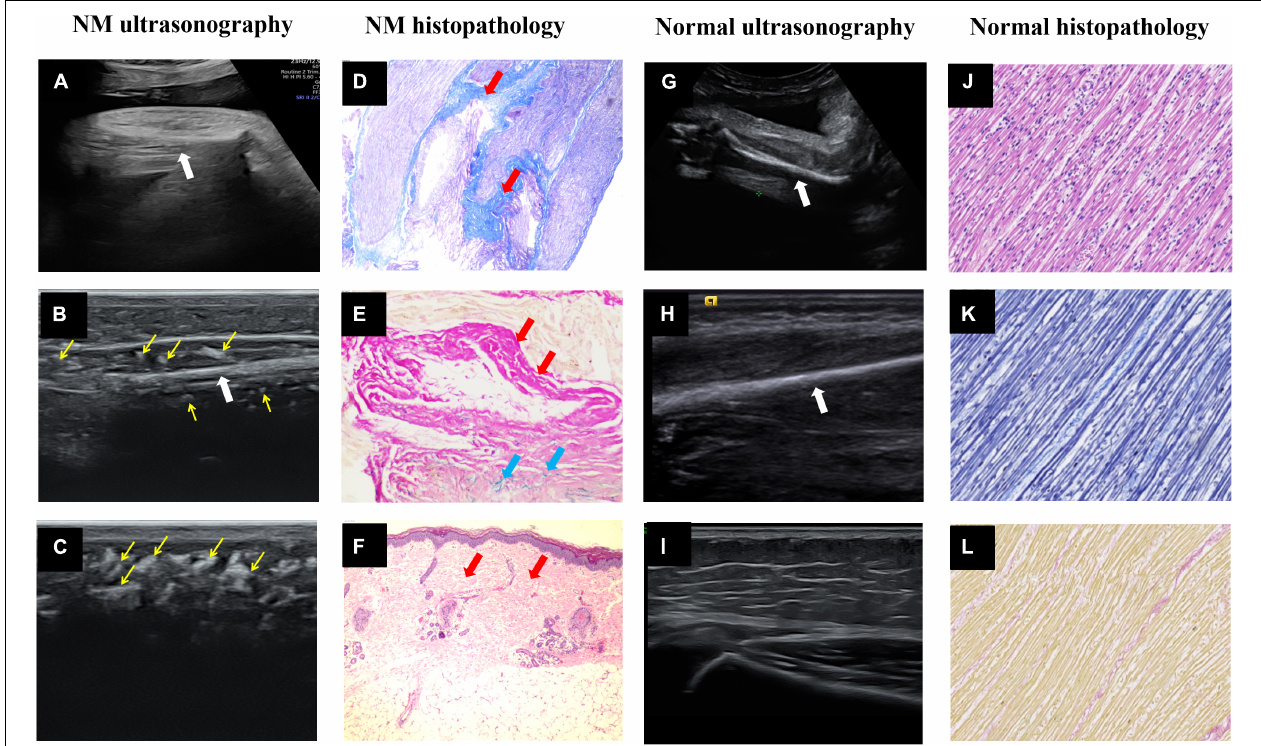
FIGURE 1 | Ultrasound images and histopathology of the prenatal and postnatal extremities. (A) Intrauterine ultrasound examination. (B,C) Postpartum high-frequency probe examination showed NM fetal upper limb muscle echo close to the humerus echo, and many hyperechoic regions (thin yellow arrows) in the muscle layer and subcutaneous tissue. (D) Right calf muscle Masson trichrome staining × 40 and (E) right calf muscle elastic fiber staining × 200. The muscle fiber fascicles were sparse and replaced by collagen fibers (thick red arrows) and elastic fibers (thick blue arrows). (F) Right calf skin H&E × 40 showed fibrous tissue (thick red arrows) proliferated in the dermis layer and subcutaneous tissue. (G–I) The normal fetal upper limb muscle echo was significantly lower than the humerus echo, and the subcutaneous tissue had low echo intensity with several echogenic septa of connective tissue. The thick white arrows point to the long bones of the fetal limbs. (J–L) The normal fetal right calf muscle H&E × 40, Masson trichrome staining × 40 and elastic fiber staining ×